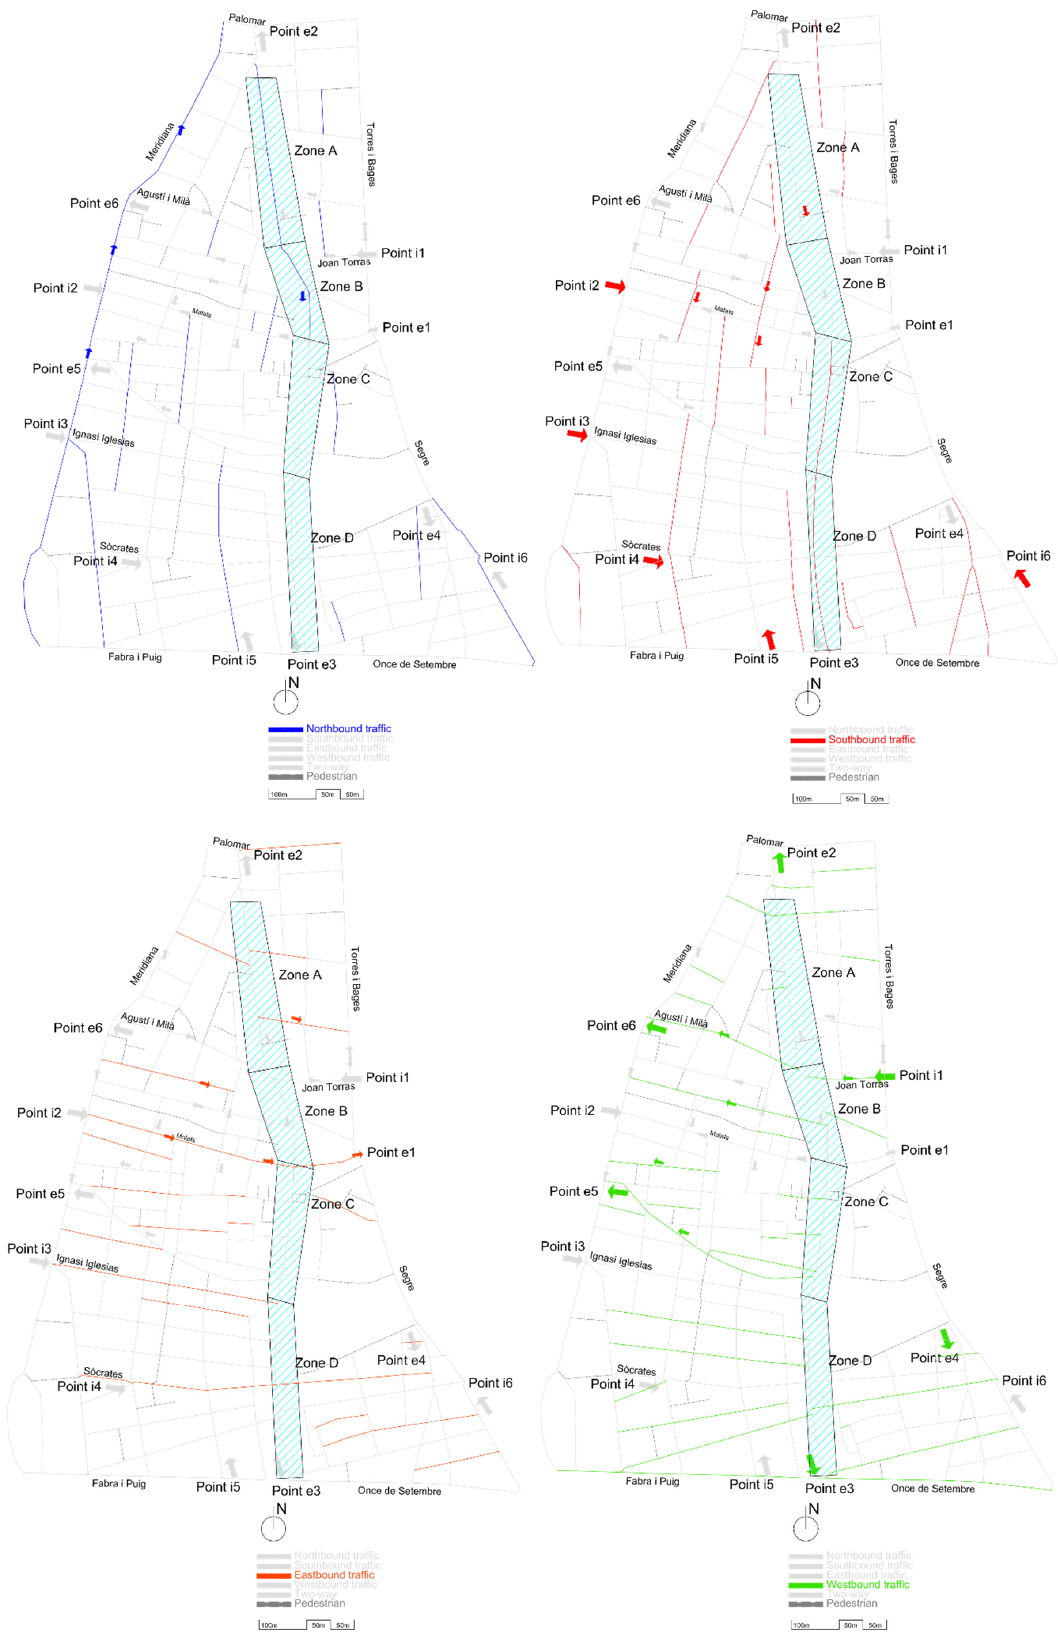
Figure 3. Direction of the traffic by street after the pacification of Gran Street.